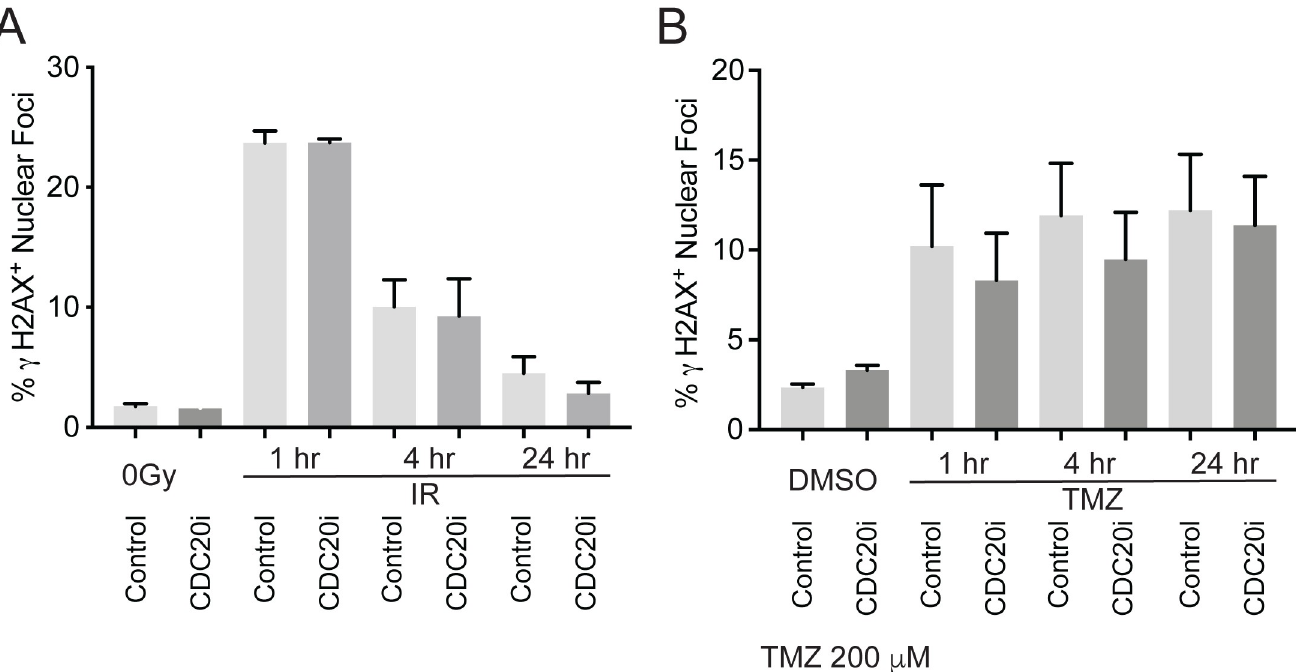
Fig 3. CDC20 knockdown does not affect DNA damage following TMZ or radiation treatment. (A) B36 GSCs transduced with lentiviruses CDC20 RNAi or control SH002 RNAi were selected with puromycin and plated at the indicated density 7 days post-transduction, and then treated with 2 Gy IR the following day. Cells were then processed for γ -H2AX immunofluorescence at the indicated time points. Data represent mean +/- SEM (n = 3). (B) B36 GSCs transduced and plated as in (A) were treated with 200 μ M TMZ the following day. Cells were then processed for γ -H2AX immunofluorescence at the indicated time points. Data represent mean +/- SEM (n =